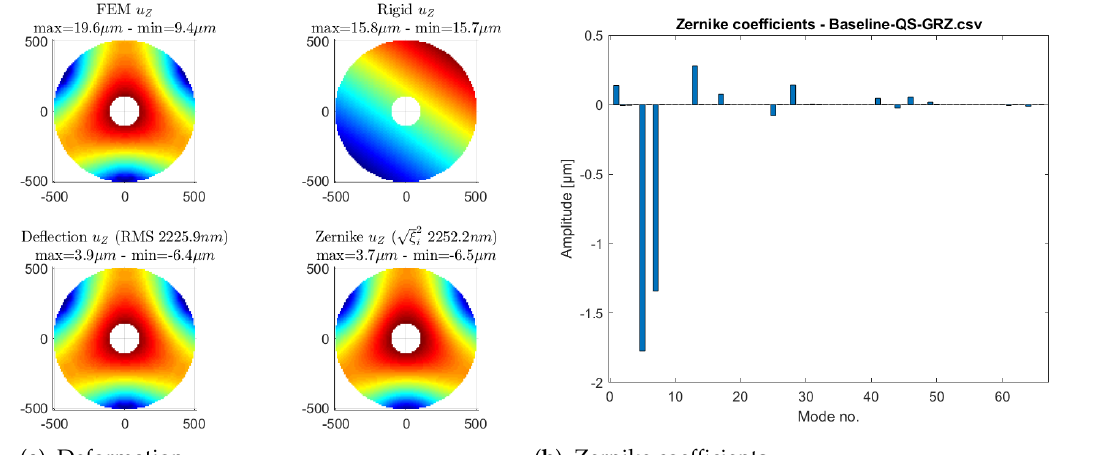
Figure 6. Baseline design with out-of-plane loading and outside support.